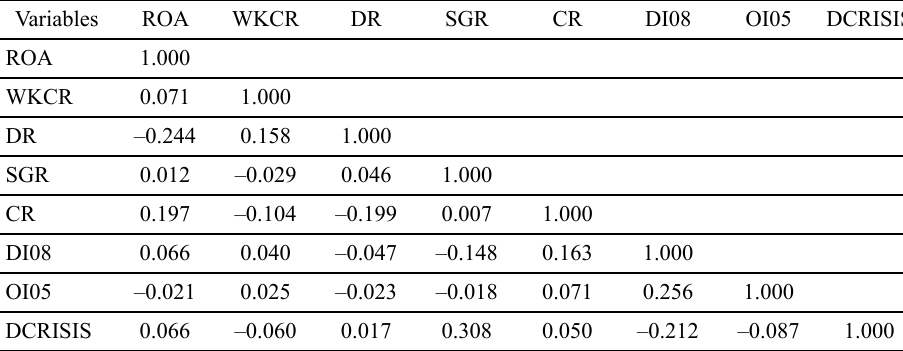
Table 2. Correlation